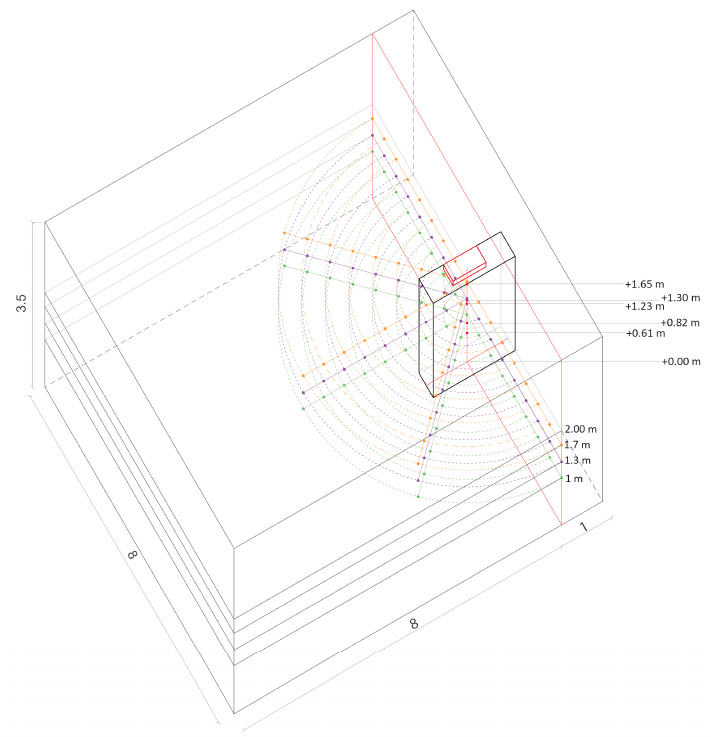
Figure 5. Grid and measurement points in a care room of the HUC for the AS-RFID reader assess- ment.